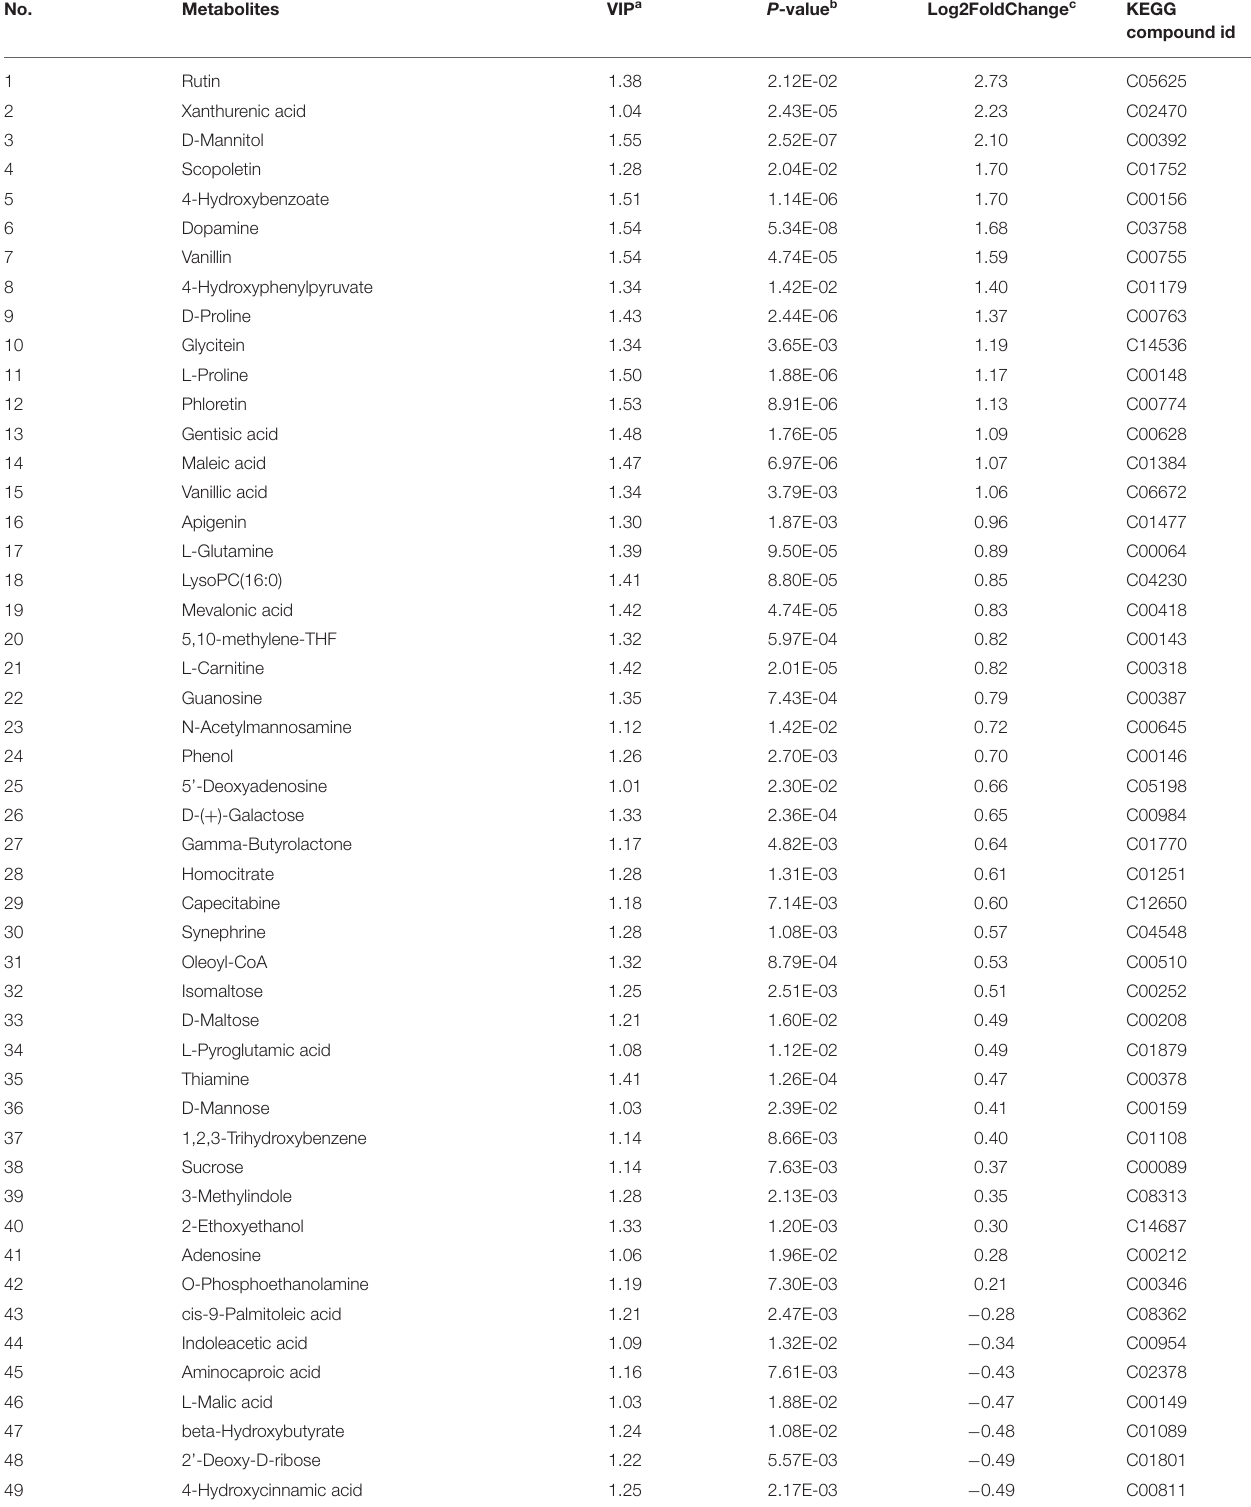
TABLE 2 | DAMs between C Las-infected and healthy